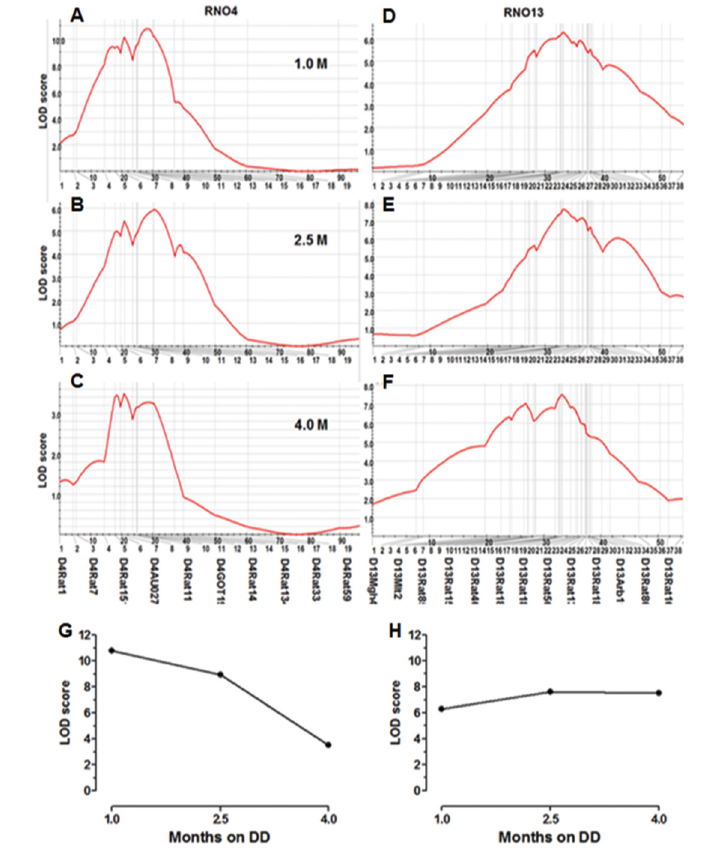
Figure 3. Logarithm of the odds (LOD) score of linkage analysis for OGTT AUC at 180 min on RNO4 (panels A, B and C) and RNO13 (panels D, E and F) after 1, 2.5 and 4 months of feeding with DD. Maximal LOD score of linkage analysis for OGTT AUC at 180 min loci on RNO4 (panel G) and RNO13 (panel H) after 1, 2.5 and 4 months of feeding with